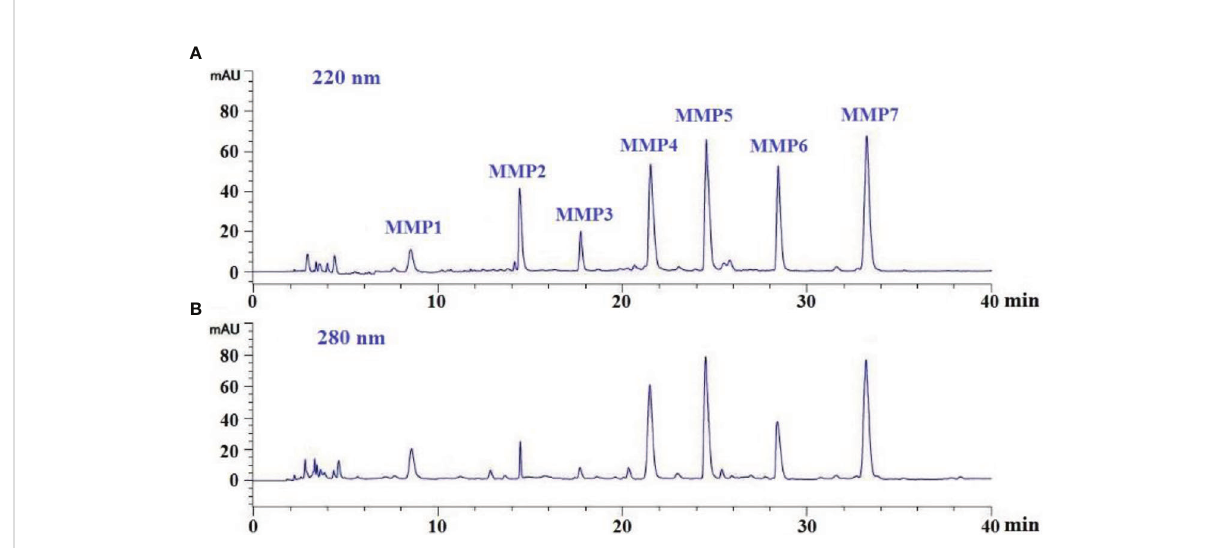
FIGURE 3 Elution pro fi les of sub-fraction MSCH-1b by RP-HPLC at 220 nm (A) and 280 nm (B) .